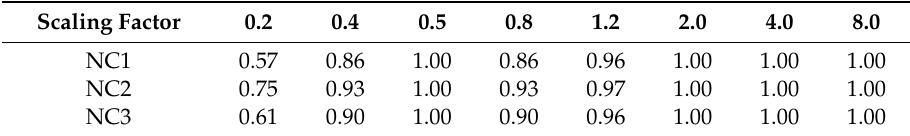
Table 7. Data of scaling attacks.